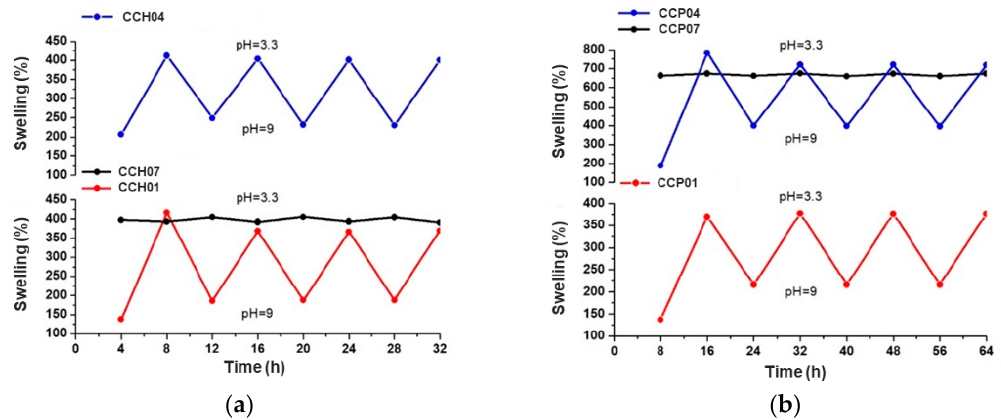
Figure 5. pH reversibility for different systems: ( a ) CCH01, CCH04, and CCH07 nanocomposites modified with HDTMA; ( b ) CCP01, CCP04, and CCP07 nanocomposites modified with PTMA.